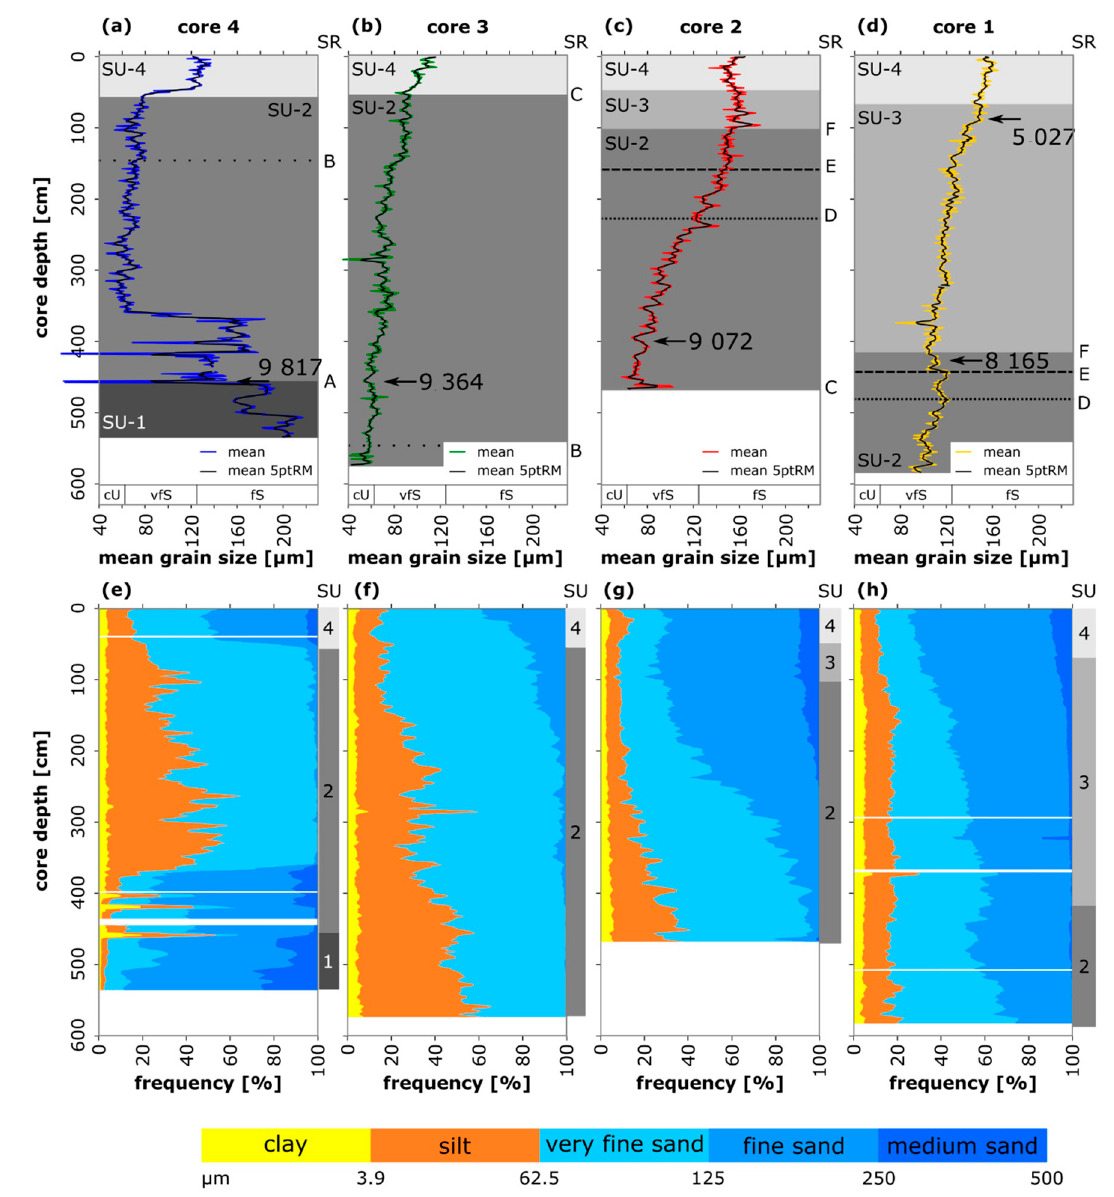
Figure 8. Grain-size analysis for coring sites 1–4. Top ( a – d ): mean grain size with 5-point running mean. The gray boxes represent the different seismic units (SU). The dashed lines represent specific seismic reflectors (SR). Bottom ( e – h ): frequency of size classes.